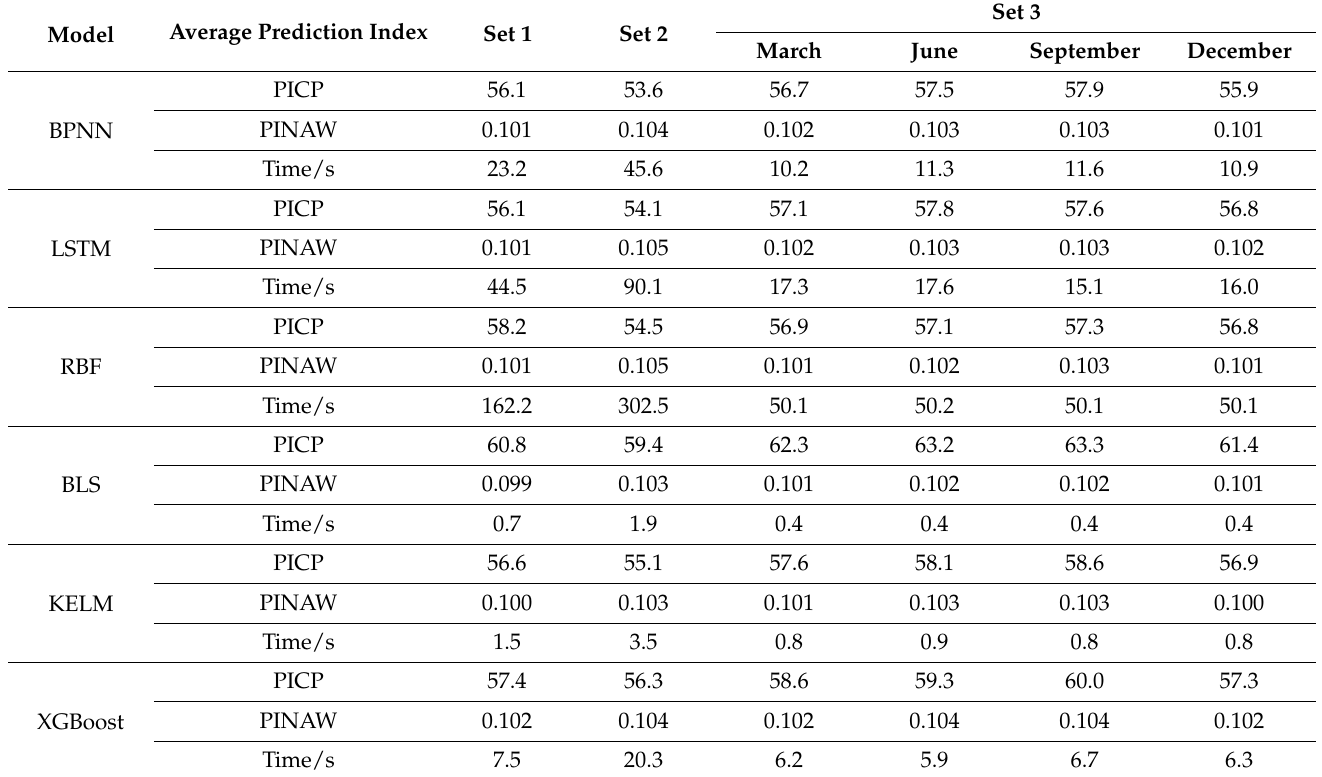
Table 1. Average accuracy comparison between different models in different